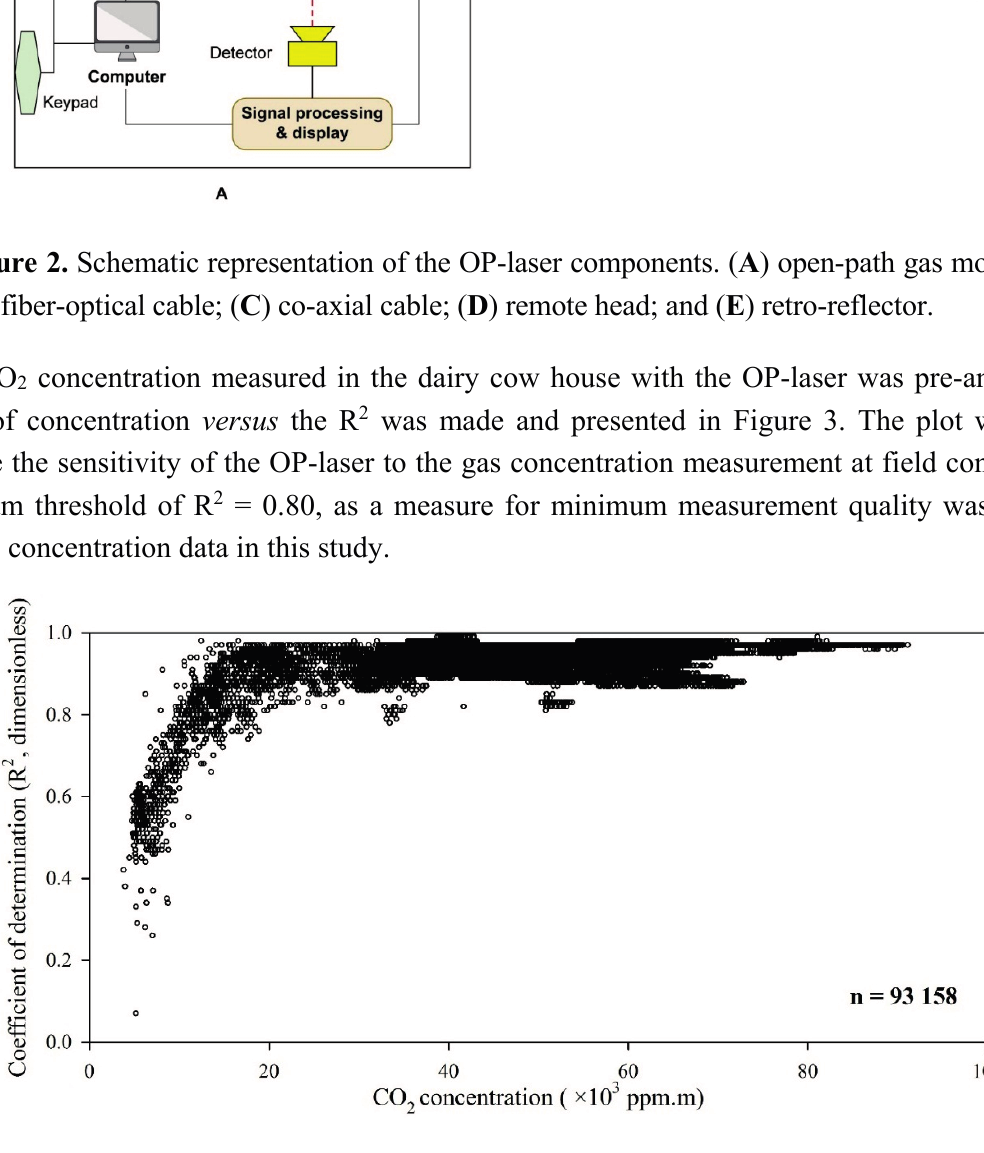
Figure 3. Improvement of the coefficient of determination (R 2 ) with increase in CO 2 concentration (ppm·m) measured at the dairy cow house with the OP-laser (path length 64